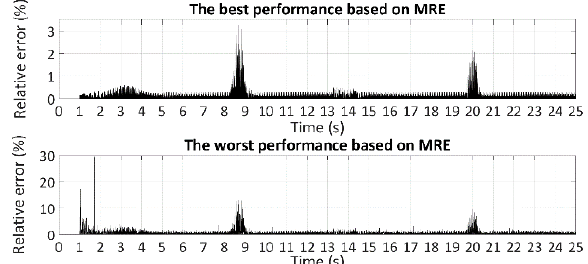
Figure 7: Best performance (above) and worst performance (below) on the adapted input variable.